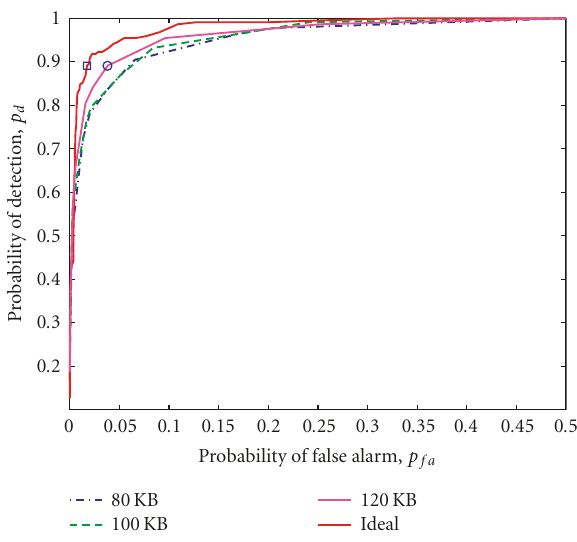
Figure 7: Best achievable ROC curves for message lengths 80 KB, 100 KB, and 120KB. These are obtained by taking the upper enve- lope of each curve in Figure 6 (so each line segment corresponds to a di ff erent choice of M and K ). The “ideal” curve is generated by applying our algorithm using all features from each image and no